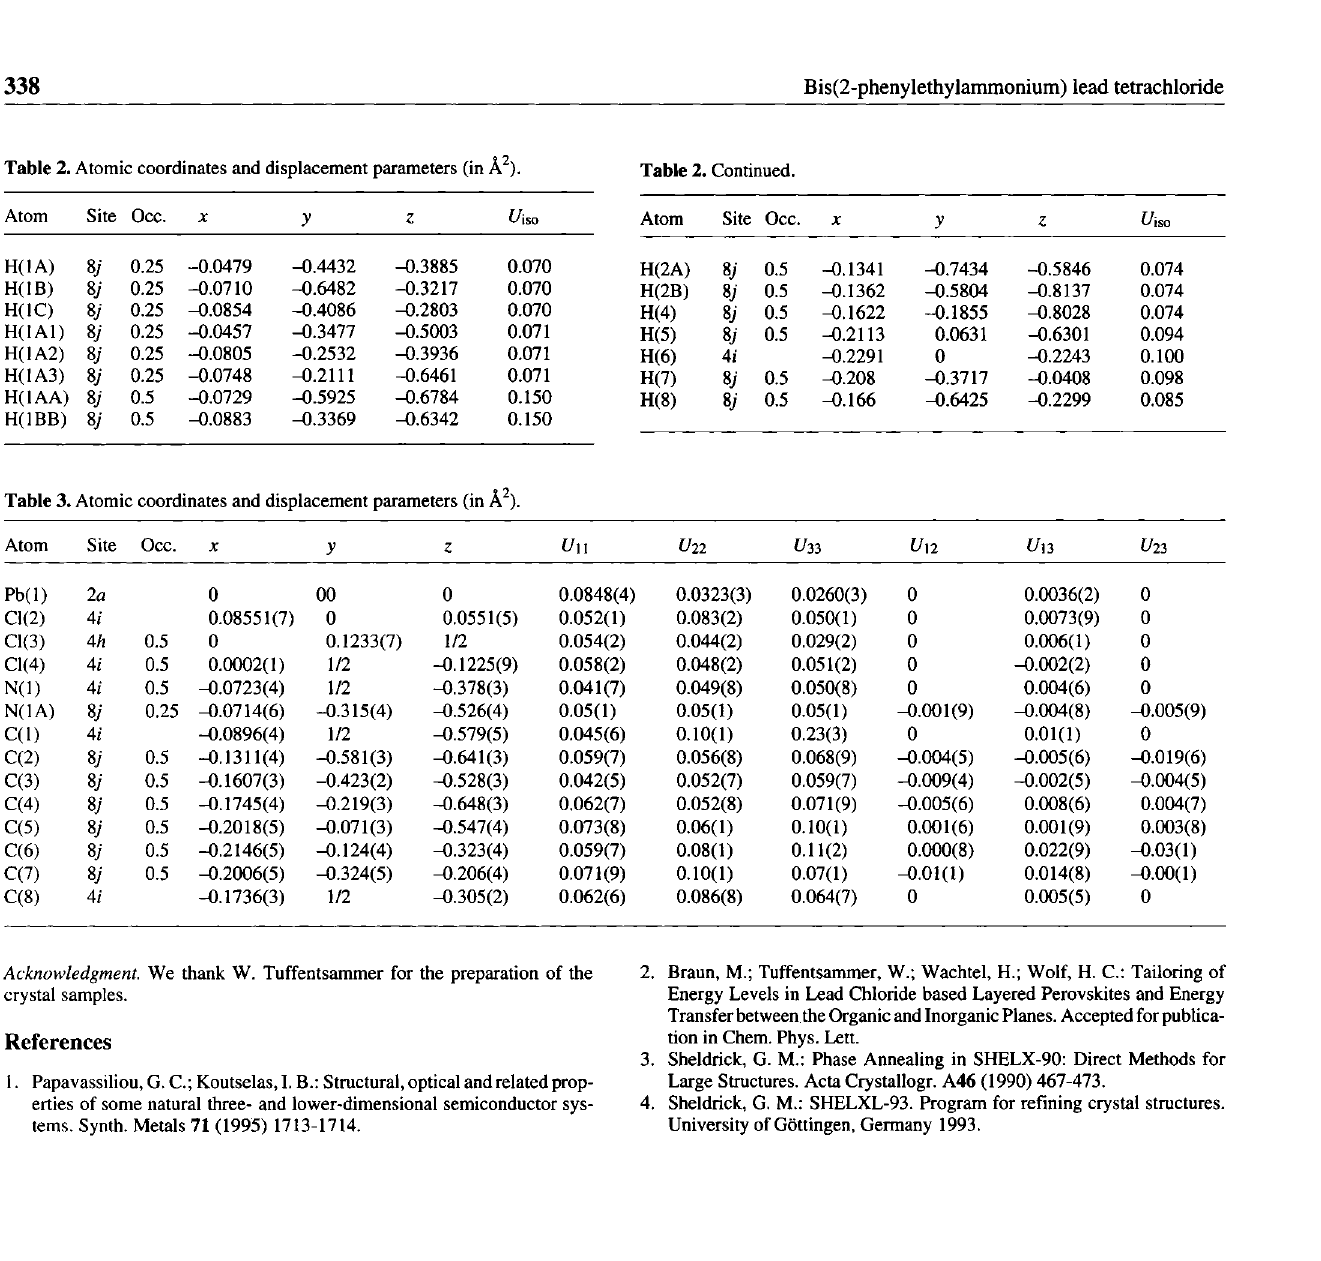
Table 2. Atomic coordinates and displacement parameters (in Â 2 ).